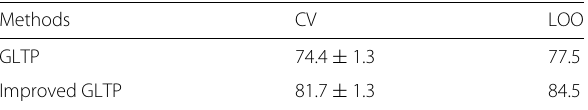
Table 10 Recognition rate (%) for 7-class emotion in JAFFE dataset using GLTP and Improved GLTP